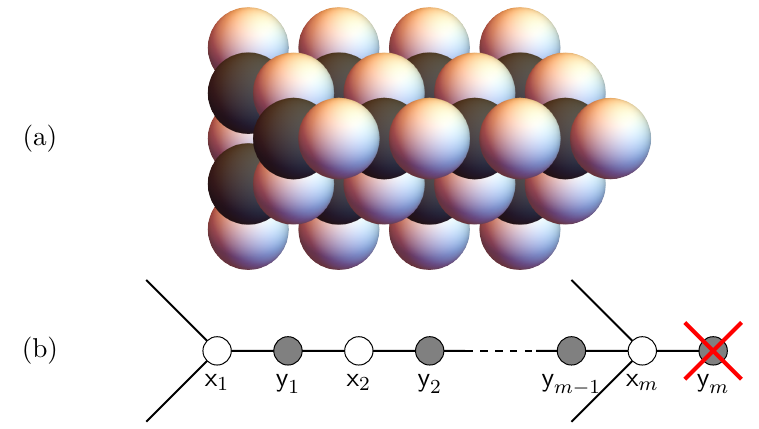
Figure 13 . (a) The crystal for the “half-infinite” chamber of the resolved conifold, i.e. a half-infinite pyramid, with m = 4 . (b) The locations of the starters x k = 1 , 2 , . . . , m − 1 , and a single stopper y